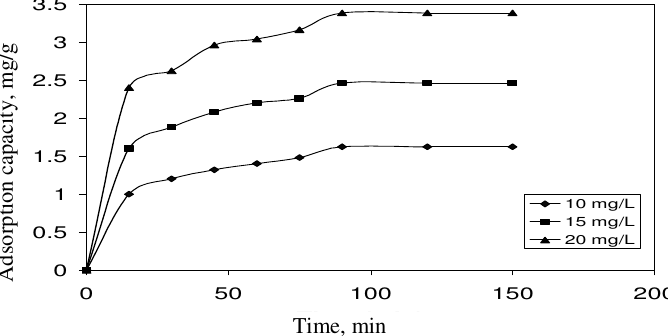
Figure 6. Influence of time on biosorption of fluoride on